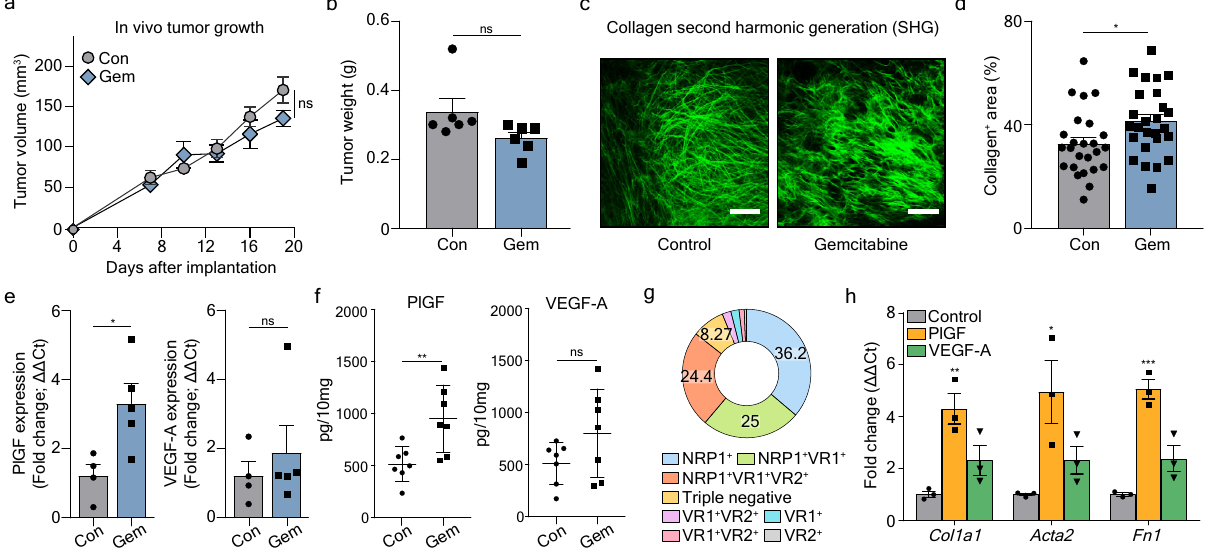
Fig. 1 | Gemcitabine induces tumor fi brosis through increased PlGF/VEGF-A expression, which activates cancer-associated fi broblasts (CAFs). On day 10 when tumor volume reached 50 – 100mm 3 , tumor-bearing mice were intraper- itoneally treated with either PBS (control, n =6) or gemcitabine (50mg/kg every 3 days for fi ve times, n =6). a Tumor volumes of control (Con) and gemcitabine (Gem) treated mice. ns, no signi fi cance. Two-way ANOVA with Sidak ’ s multiple comparisons test was performed. b Tumor weights of control (Con) and gemcita- bine (Gem) treated mice ( n =6/group) compared at the end of the experimental period. No statistical difference was observed. c Representative images showing second-harmonic generation (SHG) signals, which indicate the distribution of col- lagen. SHG signals were obtained at 840nm and pseudo-colored with green. Scale bar,100 μ m. d Averagepercentagesofcollagen + areaoutofthetotalareaintumors treatedwithPBS(control)orgemcitabine(n=25/group).Forquanti fi cation,fourto fi ve SHG images of512 μ m in width and height wereobtained per tumor. P